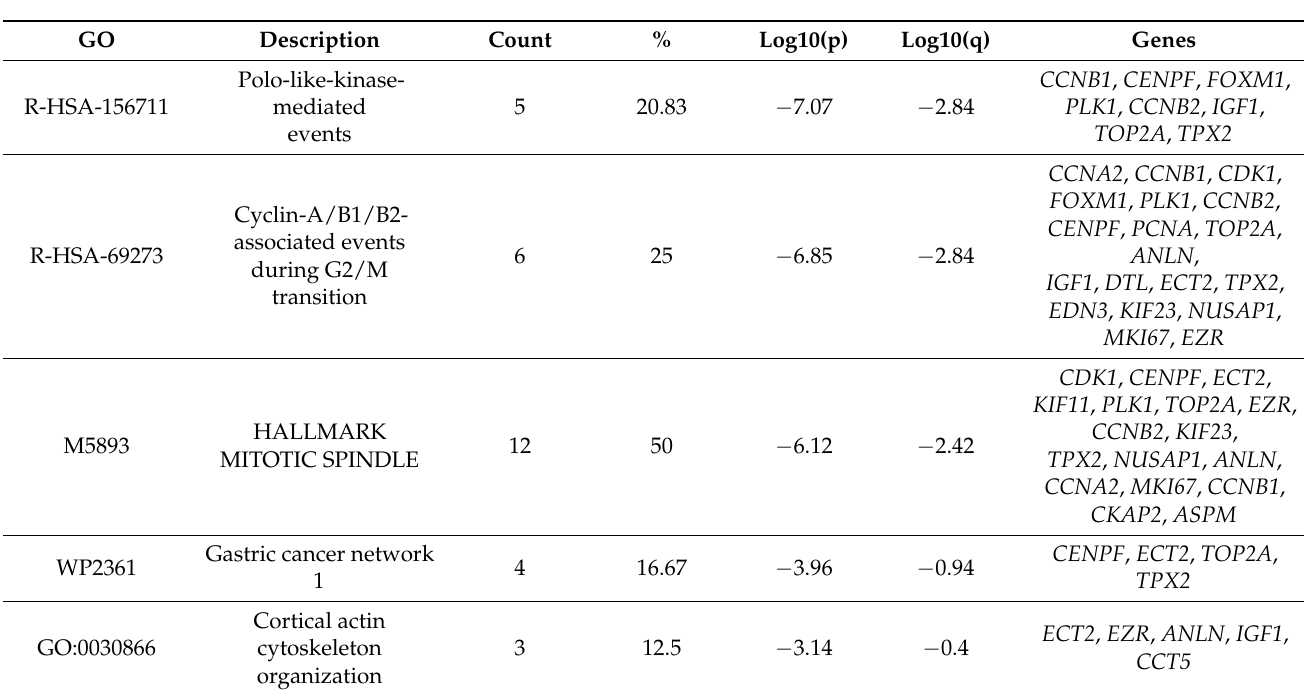
Table 3. Top 5 clusters with their representative enriched terms (one per cluster) from pathway enrichment analysis. “Count” is the number of genes in the user-provided lists with membership in the given ontology term. “%” is the percentage of all of the user-provided genes that are found in the given ontology term (only input genes with at least one ontology term annotation are included in the calculation). “Log10(P)” is the p -value in log base 10. “Log10(q)” is the multi-test adjusted p -value in log base